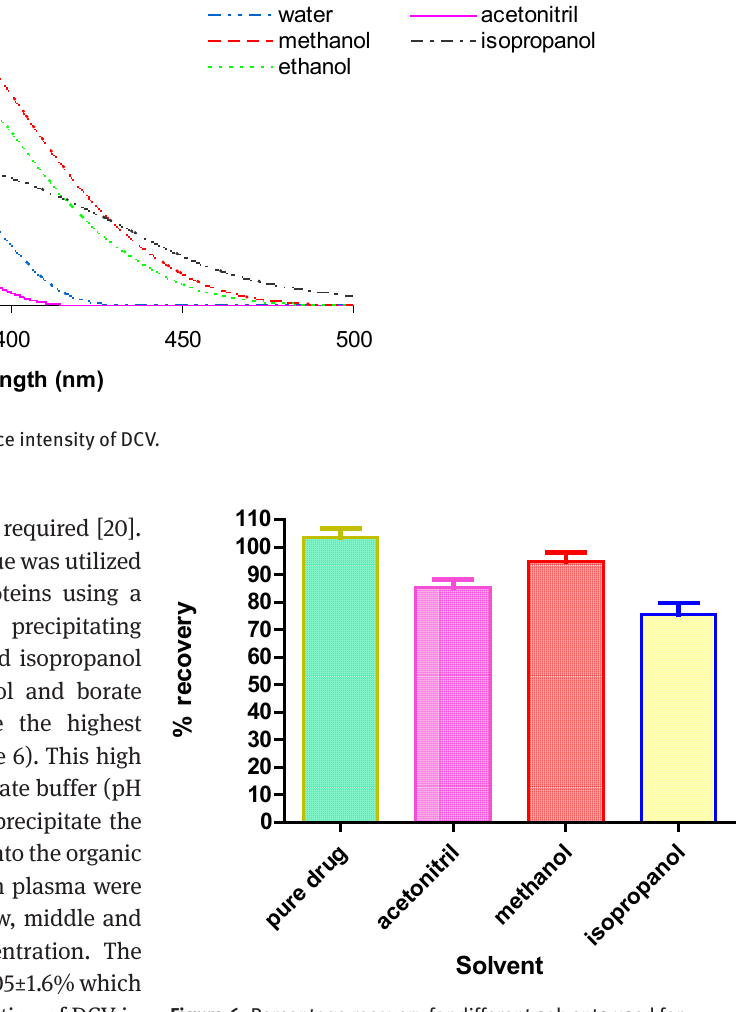
Figure 6 : Percentage recovery for different solvents used for extracting DCV from